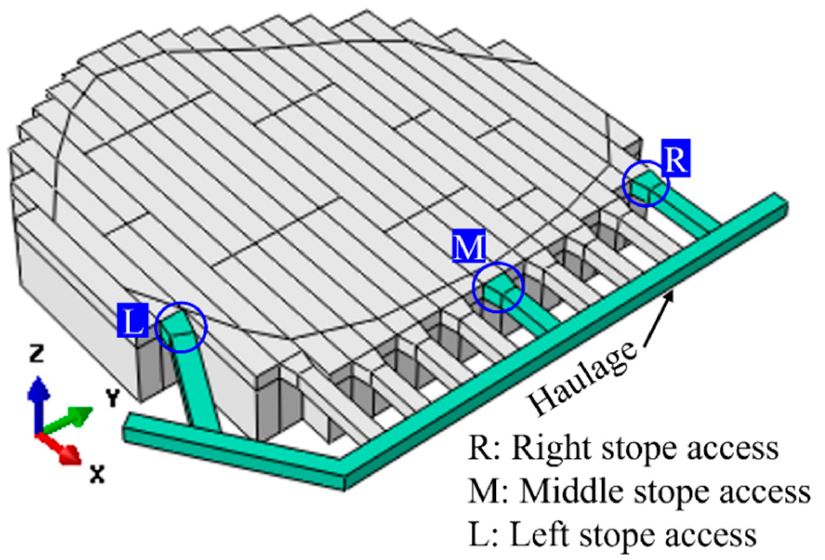
Figure 12. Analyzed stope access in sill pillar Sill-1.